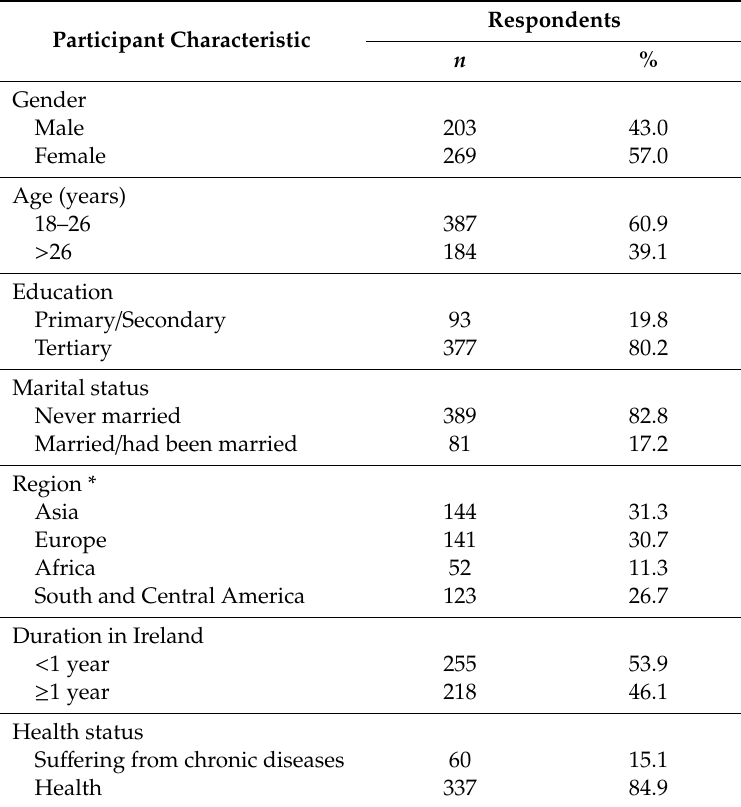
Table 1. Socio-demographic and health characteristics of the study